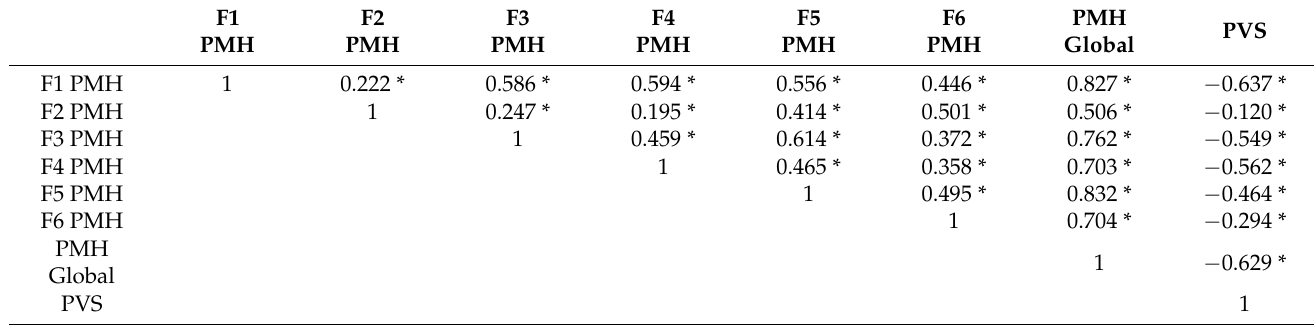
Table 4. Correlation between PMH and